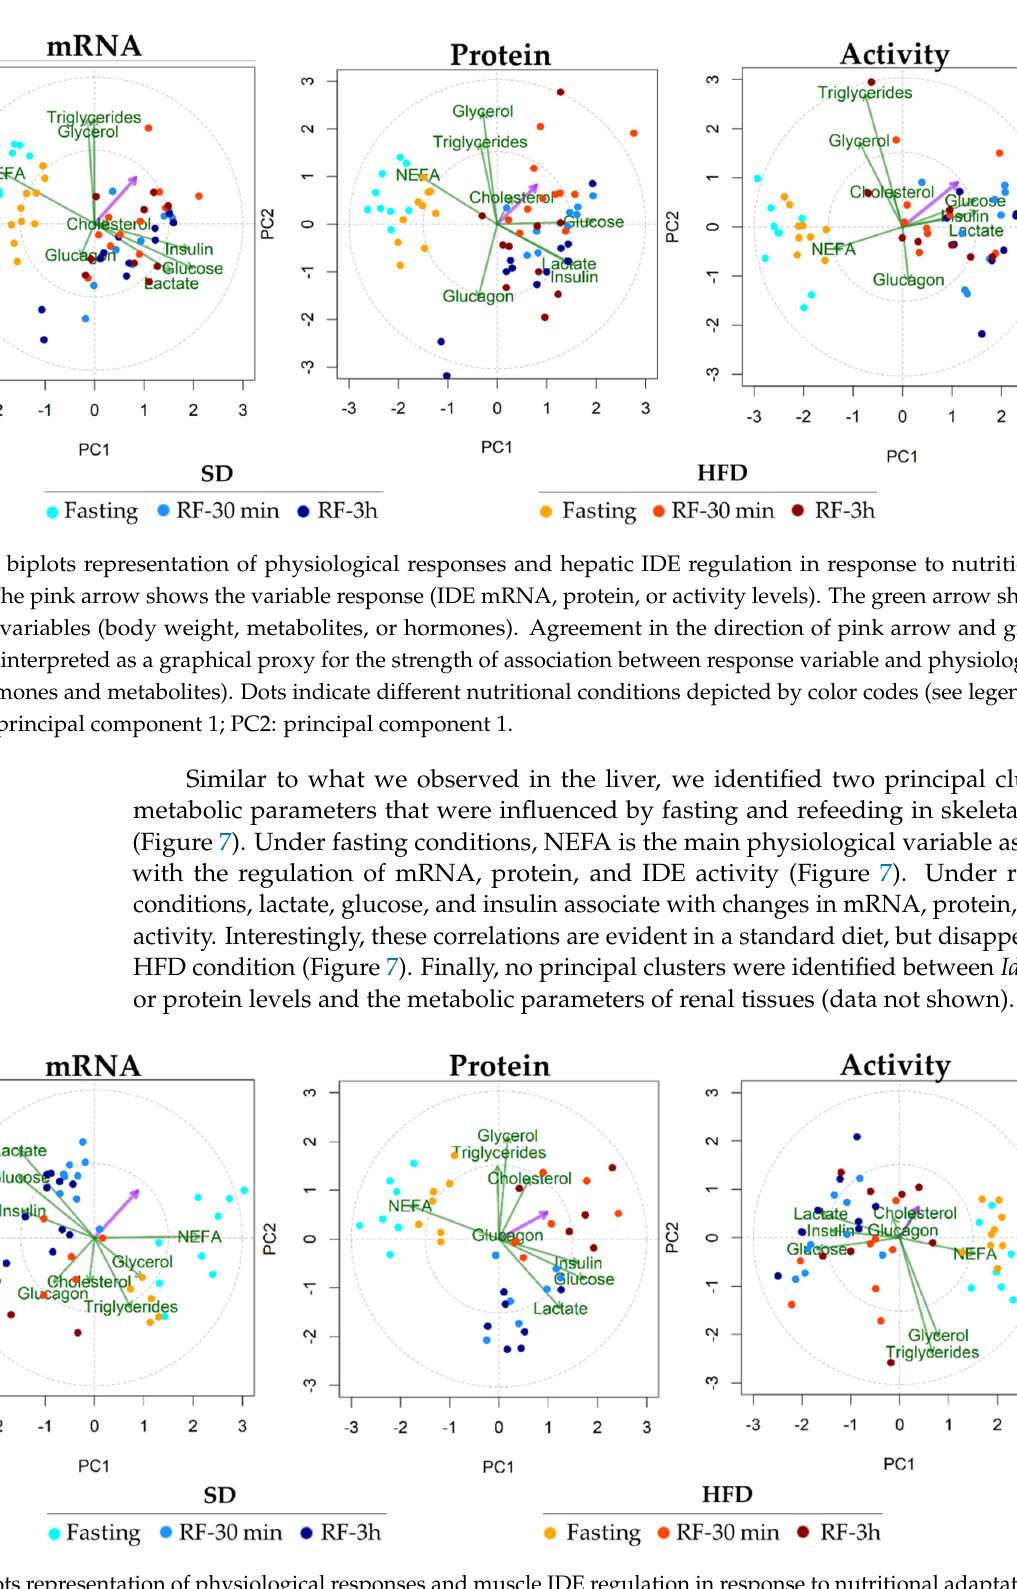
Figure 7. Biplots representation of physiological responses and muscle IDE regulation in response to nutritional adaptations. The pink arrow shows the variable response (IDE mRNA, protein levels, or activity). The green arrow shows physiological variables (body weight, metabolites, or hormones). Agreement in the direction of the pink arrow and green arrows can be interpreted as a graphical proxy for strength of association between response variable and physiological variables (hormones and metabolites). Dots indicate different nutritional conditions depicted by color codes (see legend in Figure). PC1: principal component 1; PC2: principal component